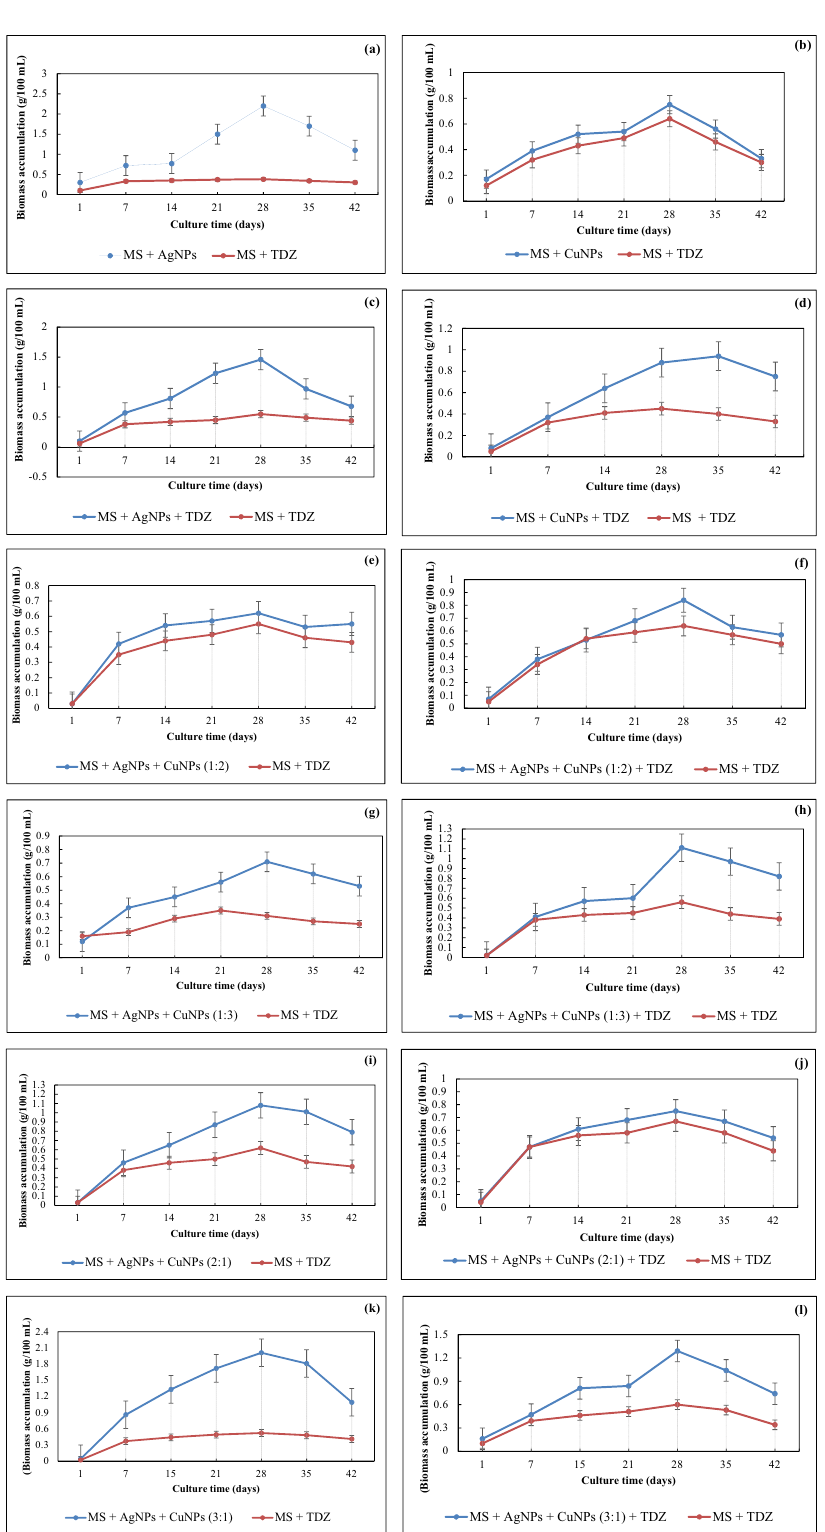
Figure 6: E ff ect of Ag NPs and Cu NPs alone and in di ff erent combinations with TDZ on biomass accumulation at di ff erent day